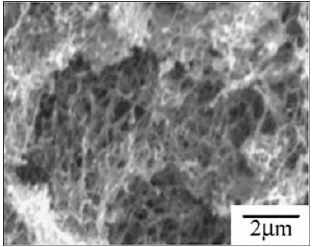
Figure 15. SEM image of the interior of a PI aerogel monolith derived from PMDA, 4,4 ΄ -ODA and TAPB. Copyright (2007) Wiley. Used with permission from Ref. [100].